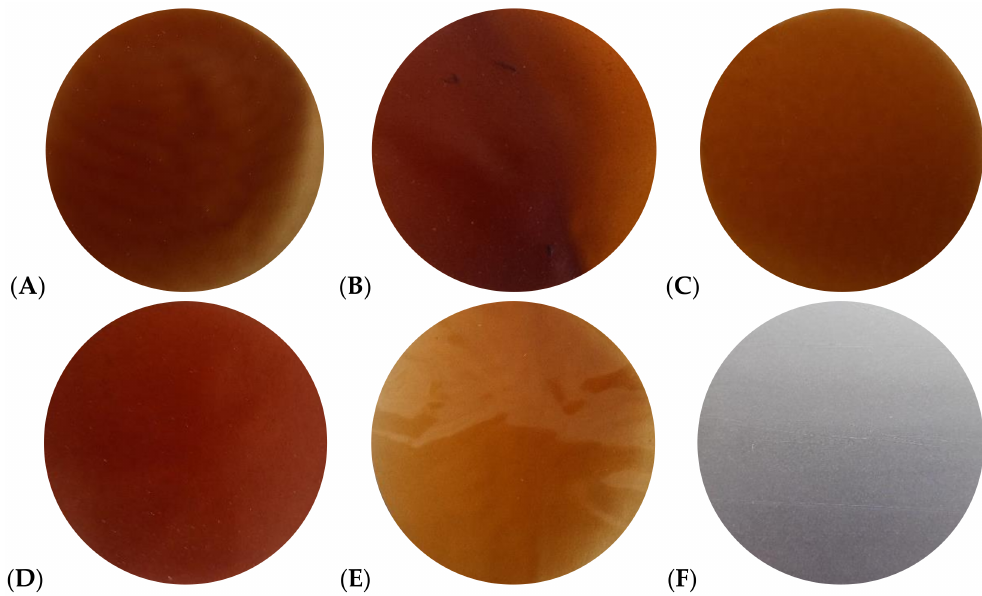
Figure 1. Physical appearance of the modified: ( A ) starch-based (ST) film; ( B ) chitosan-based (CH) film; ( C ) alginate-based (ALG) film; ( D ) starch and chitosan-based (STCH) film; ( E ) starch and alginate-based (STALG) film; ( F ) commercially available PLA-based